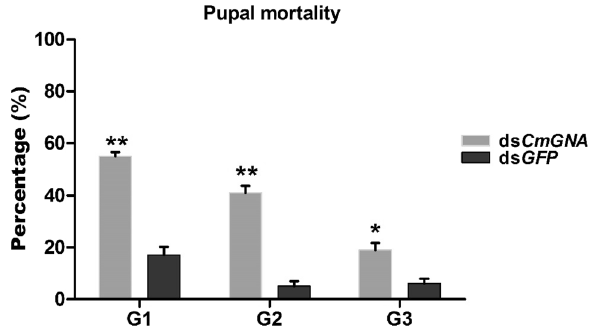
Figure 4. The percentage of dead pupae were calculated in G1–G3 generations. Each point indicates the mean ± standard error in G1–G3, and their control groups. Significant differences indicated by *(P < 0.05), **(P < 0.01).